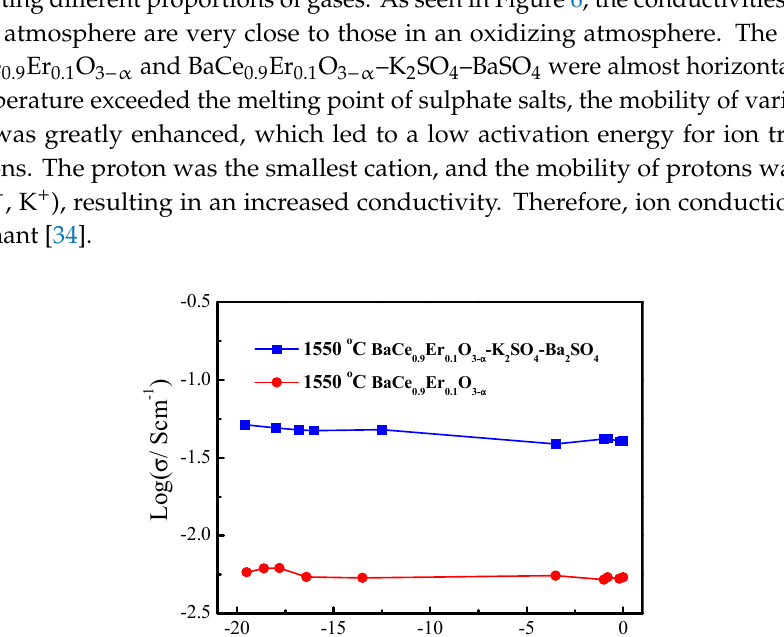
material for medium-temperature fuel cells.